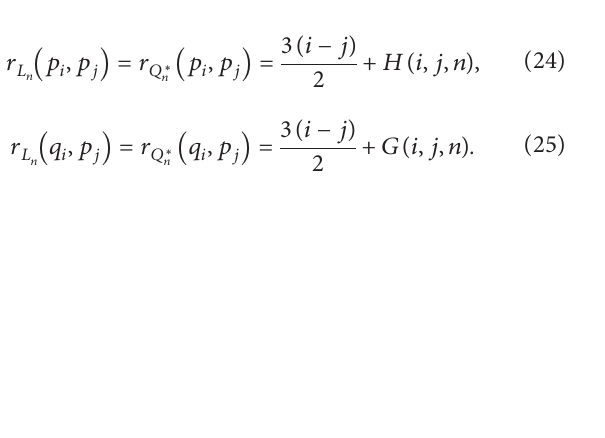
p , q p i i , and j .